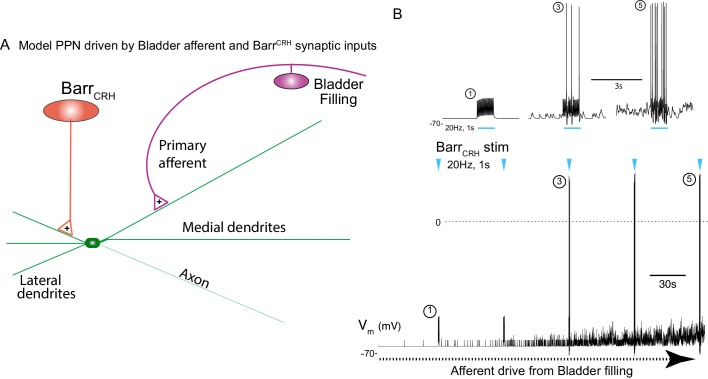
Integrative model of BarrCRH drive to bladder parasympathetic neurons in micturition cycle.(A) Model of a parasympathetic preganglionic neuron (implemented in NEURON) with a synaptic drive from Barrington’s nucleus and a second synaptic input from a bladder afferent neuron. (B) The model PPN is depolarised as the firing of the afferent neuron increases with bladder distension (afferent input from recordings Ito et al., 2019) producing an augmenting synaptic excitation (subthreshold for spike firing). Coincident 20 Hz stimulation of the BarrCRH neuron (blue arrow heads, mimicking opto-activation) evokes no parasympathetic spike output at the start of the cycle but this increases to 8–10 Hz by the end of the cycle (traces shown on expanded timebase above).